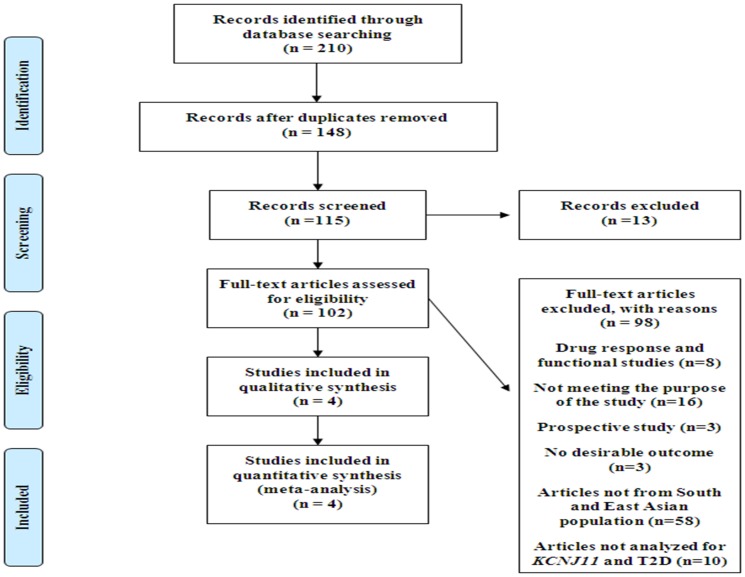
Flow diagram of study selection for KCNJ11 polymorphism (rs5219).